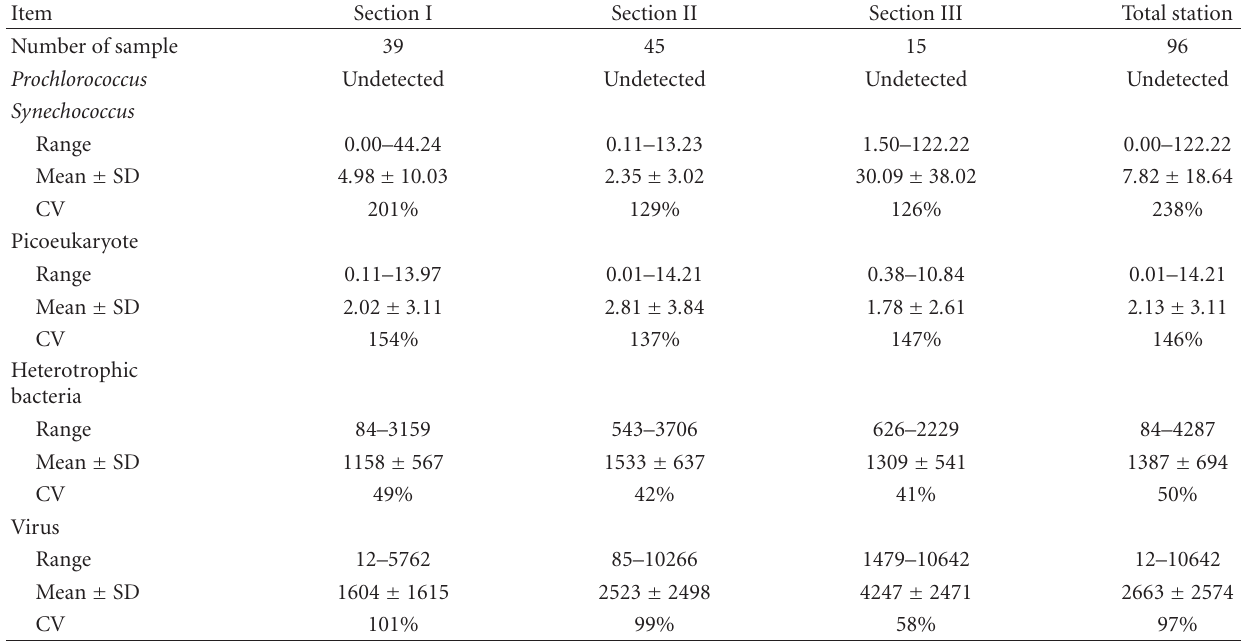
Table 2: List of the measured picoplankton ( × 10 6 cellsL − 1 ) and viruses ( × 10 6 particlesL − 1 ) in the Changjiang estuary and its adjacent sea area in June